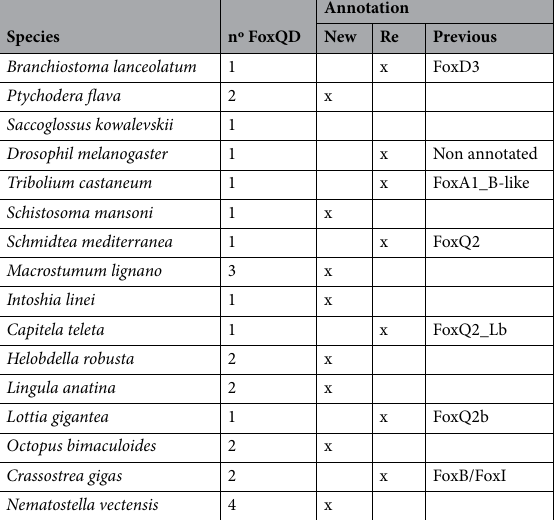
Table 2. New annotation of QD genes in different metazoan species. Number of paralogs per species is indicated. They are classified as New or Re-annotated genes. In this case, the previous family is shown.